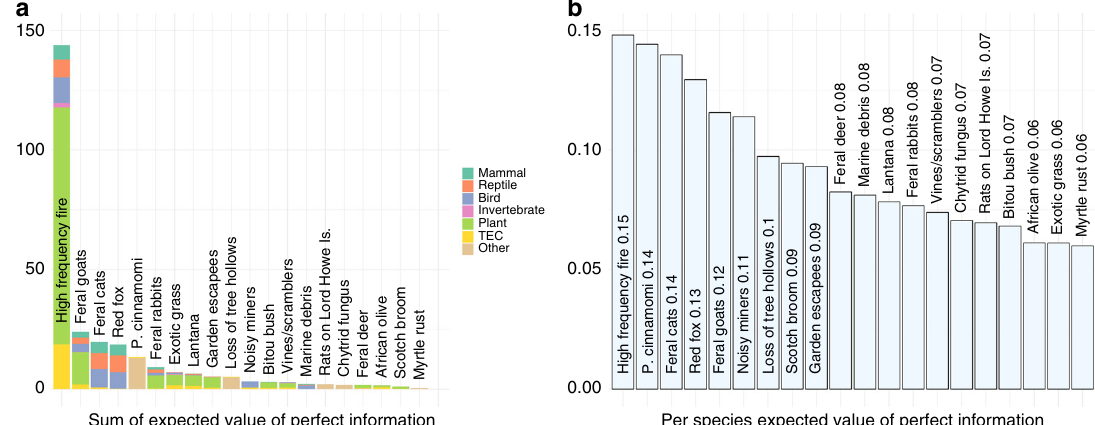
Fig. 2 Expected value of perfect information (EVPI) for each threat if uncertainty about management effectiveness was removed. Panel a depicts the total additional gain in persistence for all species affected by the threat compared to the bene fi t of managing under current uncertainty; colours depict the proportional contribution to the sum from groups of affected species. Panel b depicts the per-species additional gain in persistence, compared to the per- species bene fi t of managing under current uncertainty. Quantities in the bar labels are rounded to two decimal places NATURE COMMUNICATIONS| (2019) 10:3570 |https://doi.org/10.1038/s41467-019-11404-5|www.nature.com/naturecommunications